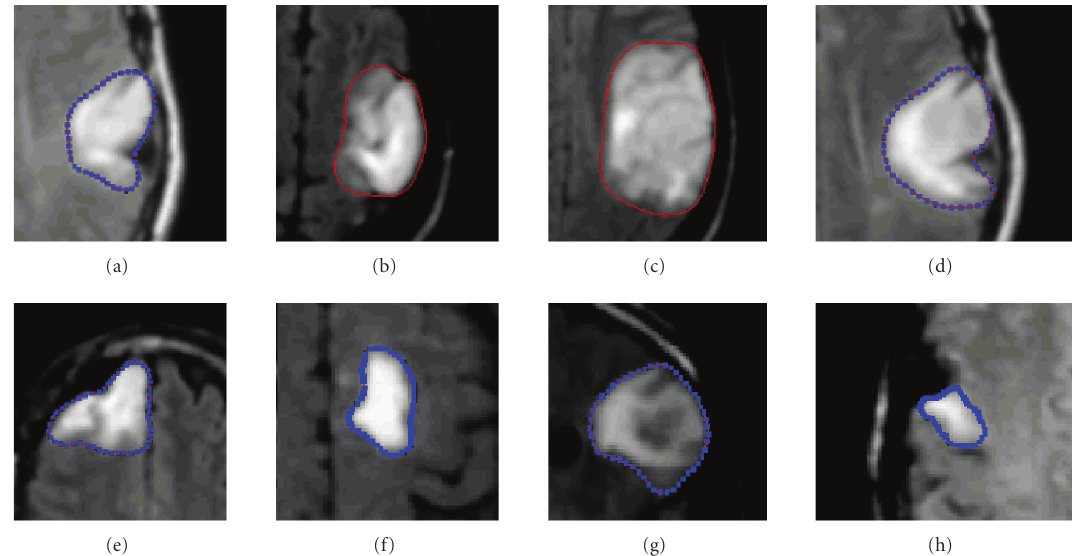
Figure 2: Segmentation of the brain tumor and the contour points. Segmentation validated by Franc¸ois Cotton (professor of